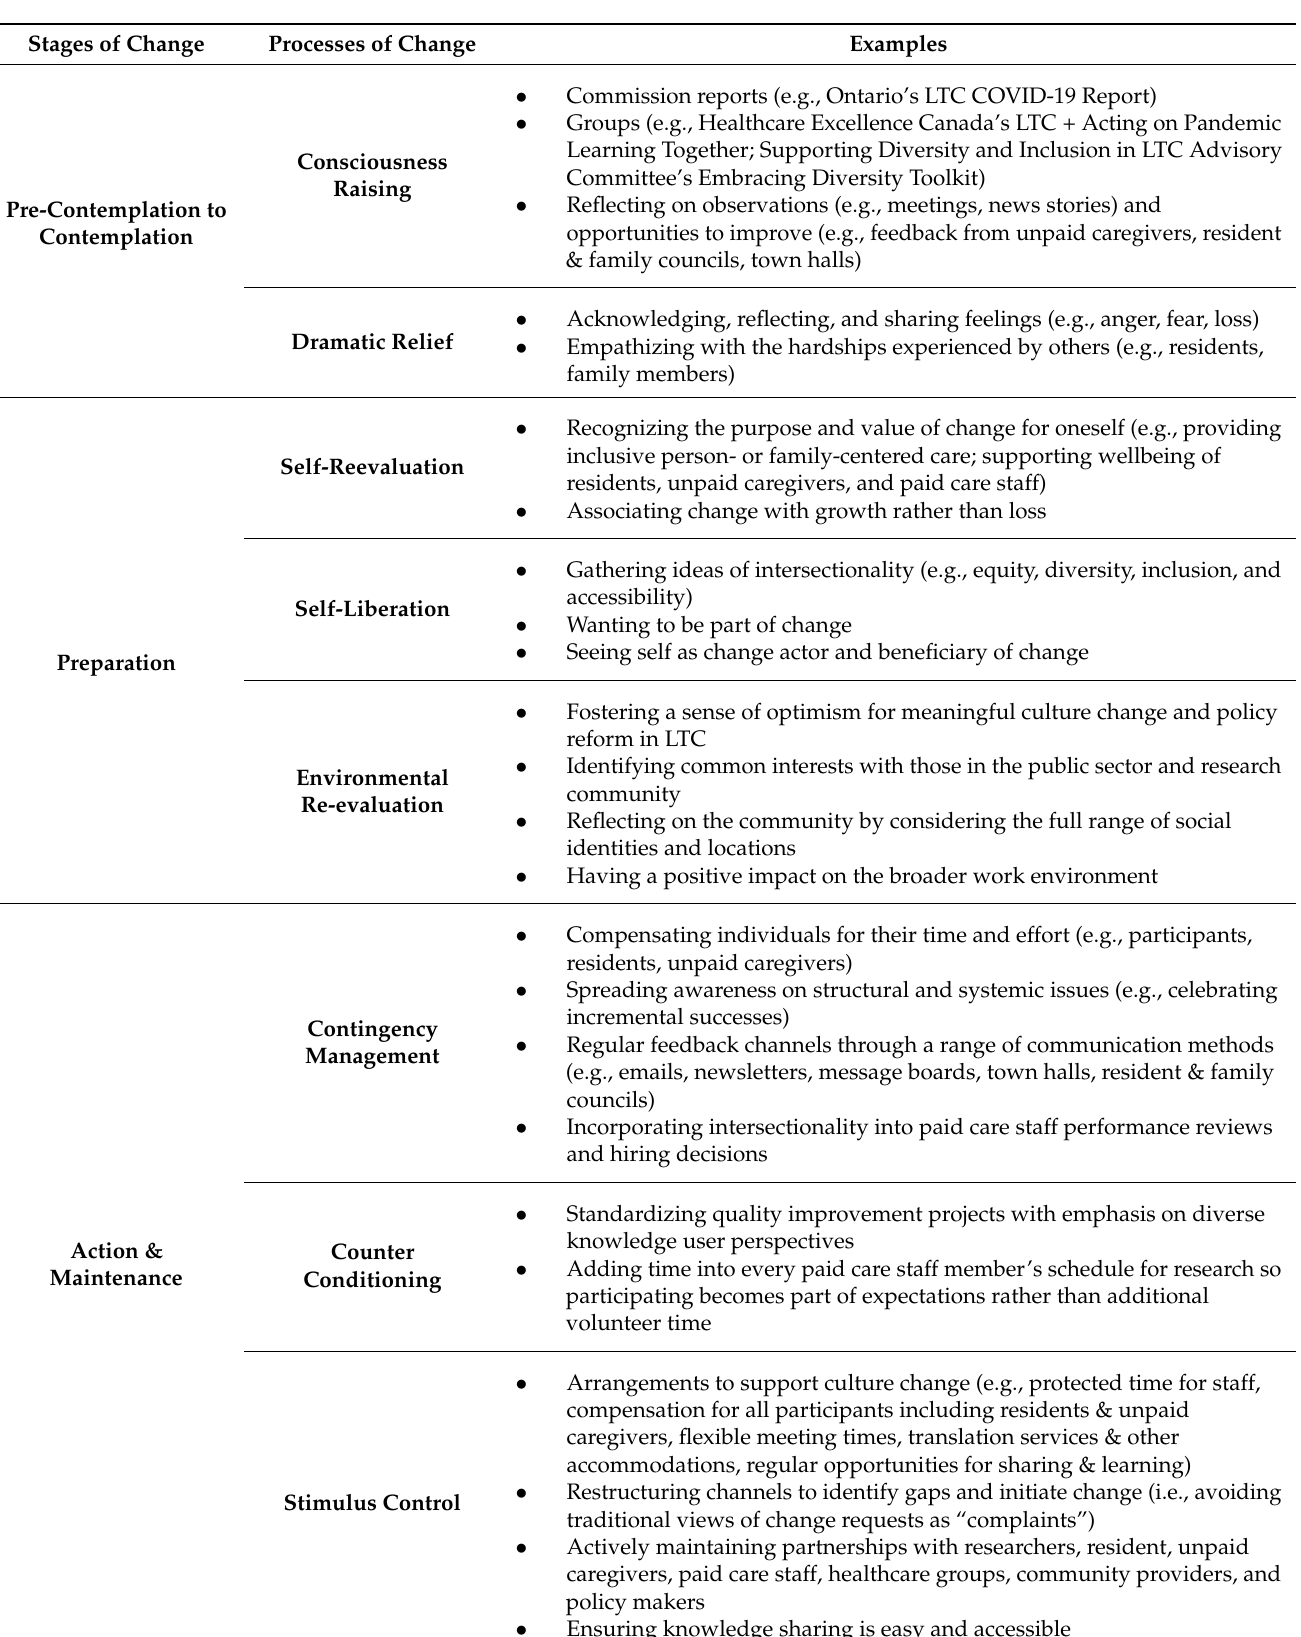
Table 1. Applying the Transtheoretical Model of Change to Long-Term Care